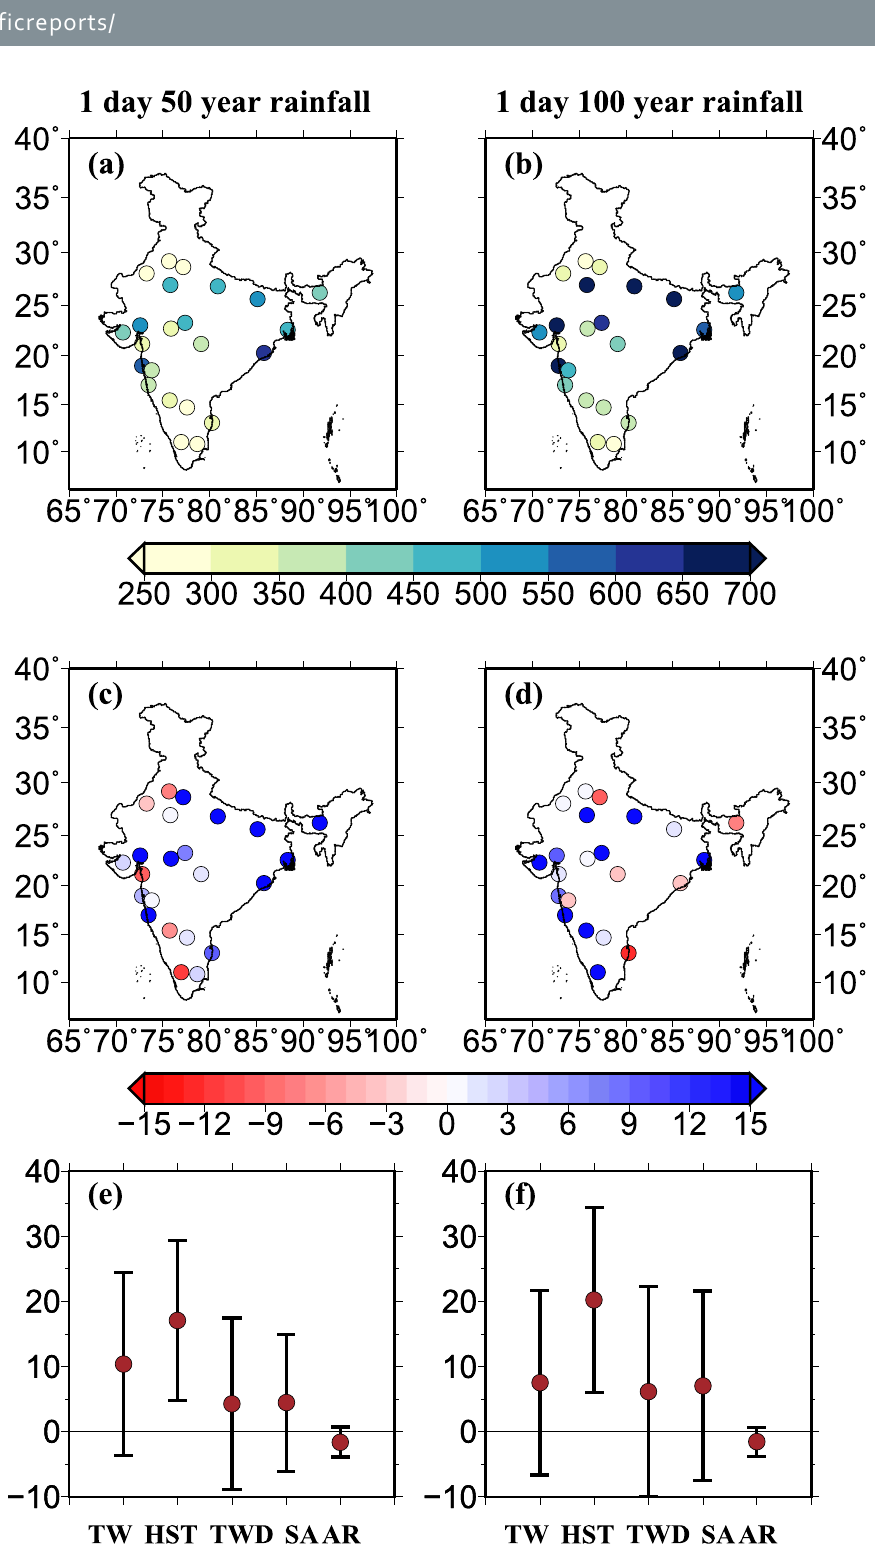
Figure 6. ( a ) 1 day 50 year rainfall maxima (in mm) for 23 cities across India assuming stationary conditions, ( b ) same as ( a ) but for 1 day 100 year rainfall maxima, ( c ) percentage bias in 1 day 50 year rainfall maxima considering stationary and nonstationary conditions, ( d ) same as ( c ) but for 1 day 100 year, ( e ) same as ( c ) but mean and standard deviation in percentage bias for different climatic zones and ( f ) same as ( d ) but for 1 day 100 year rainfall. DPT and T850 were used as covariate to account nonstationary conditions. Percentage change = × − ( ) 100 NS S in 1 day 50–100 year rainfall maxima were estimated using the stationary (S) and NS nonstationary (NS) conditions. Return values were estimated using ismev package in “R”. The figure was developed using the Generic Mapping Tools (GMT,